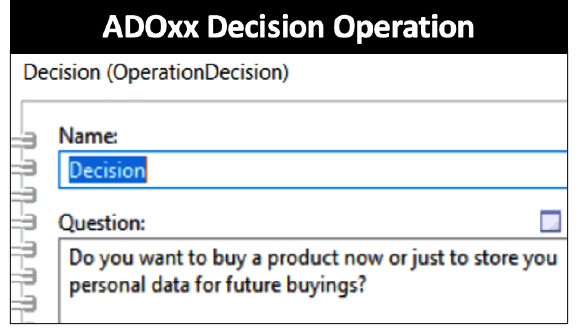
Figure 6. Attaching question text to diagram elements identified as